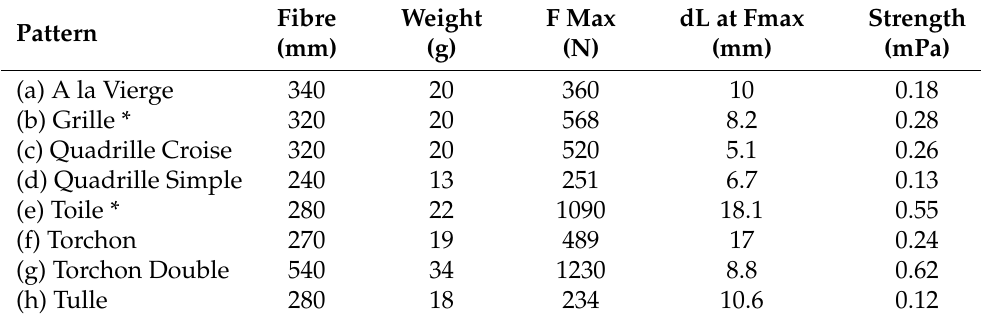
Table 1. Results of physical compression tests (Patterns marked with an asterisk are not considered for implementation in tailored lace